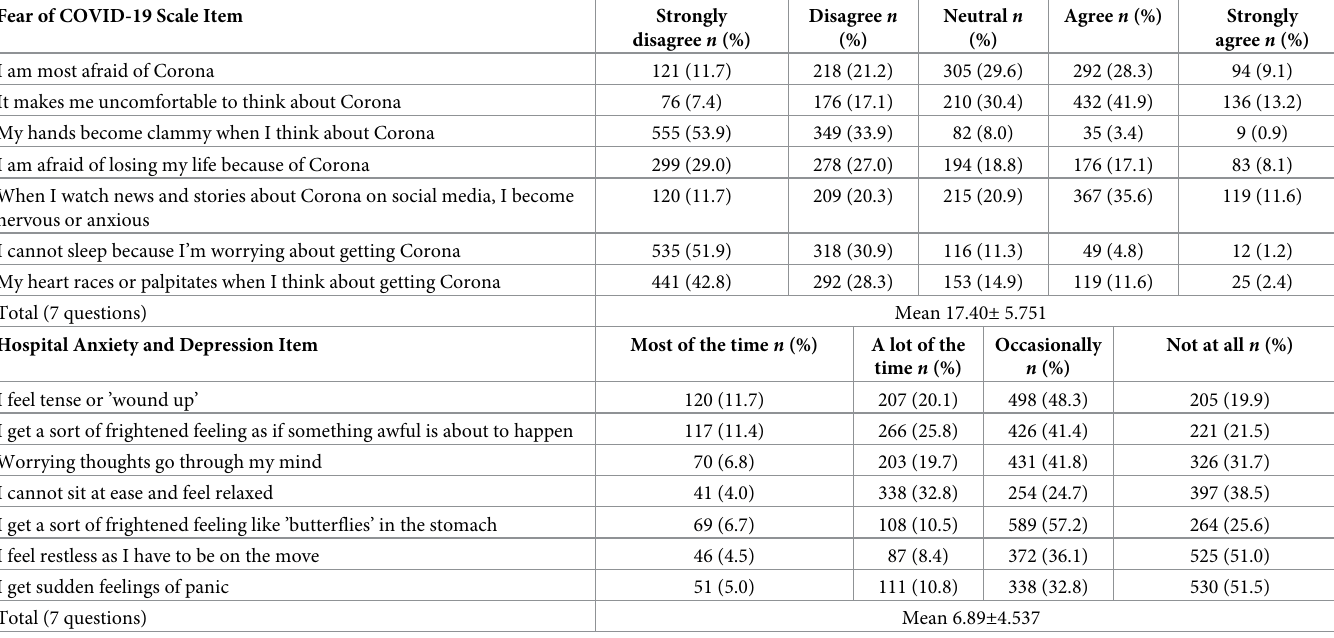
Table 2. Descriptive statistics of patients’ fear of COVID-19 and hospital anxiety and depression scales.